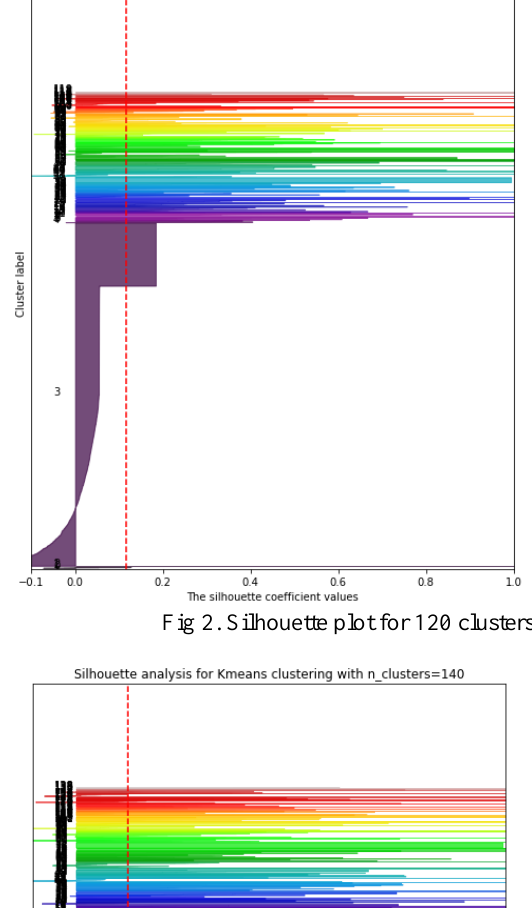
Fig 2. Silhouette plot for 120 clusters